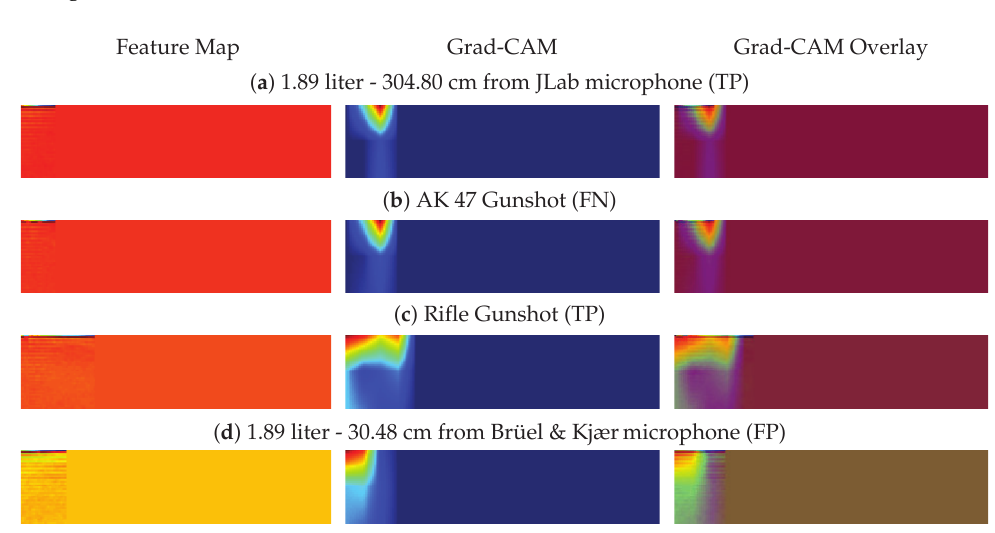
Figure 8. Comparison of the Grad-CAM visualization for the MFCC feature extraction between plastic bag explosions and gunshots.